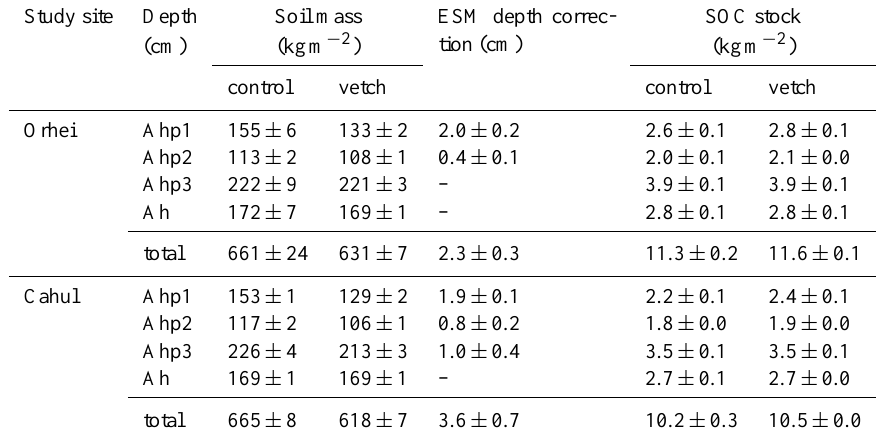
Table 3. Soil masses and SOC stocks corrected for equivalent soil masses (ESM) of topsoil horizons of control and experimental sites in Orhei and Cahul after incorporation of HVW and harvest of the main crop (mean values ± SD, n =